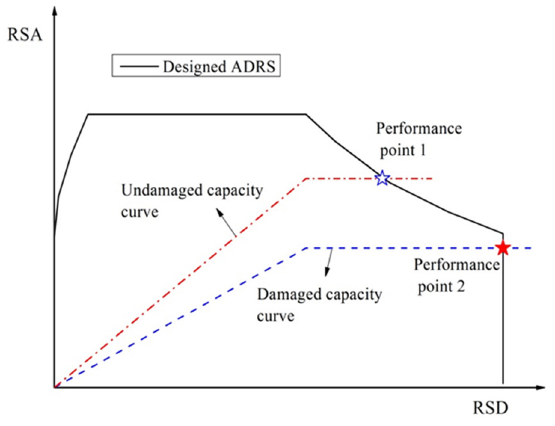
Figure 1. Design spectrum and capacity curves for damaged and undamaged structures.